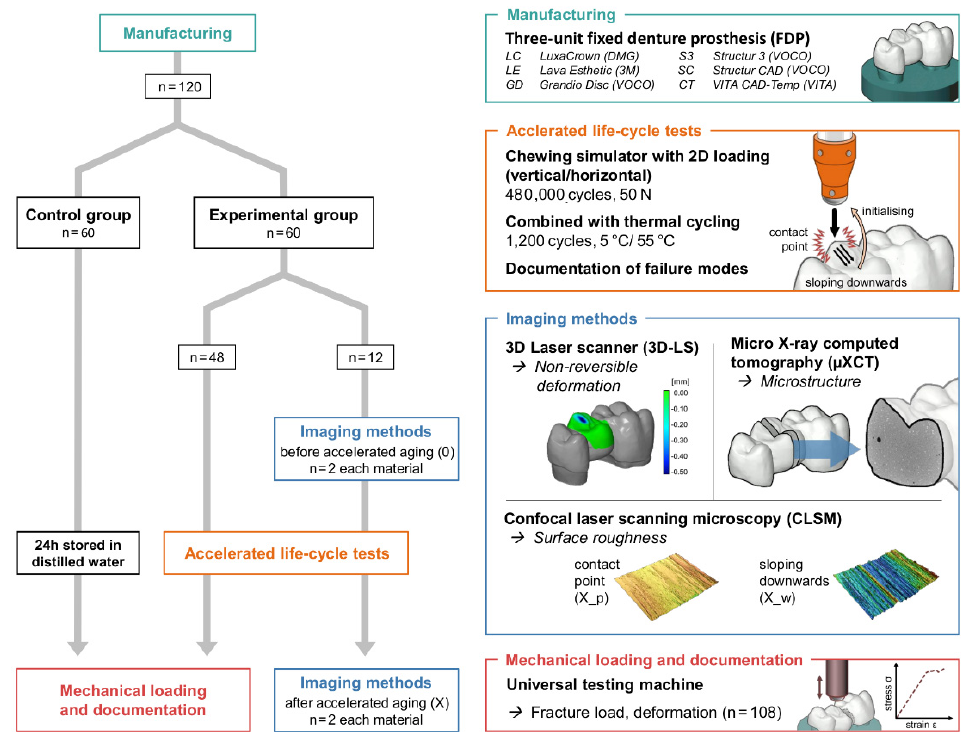
Figure 1. Flowchart of the test program with imaging techniques [micro X-ray computer tomograph (µXCT), confocal laser scanning microscope (CLSM, 2D), 3D scanner (3D-LS, 3D)] and universal testing machine.